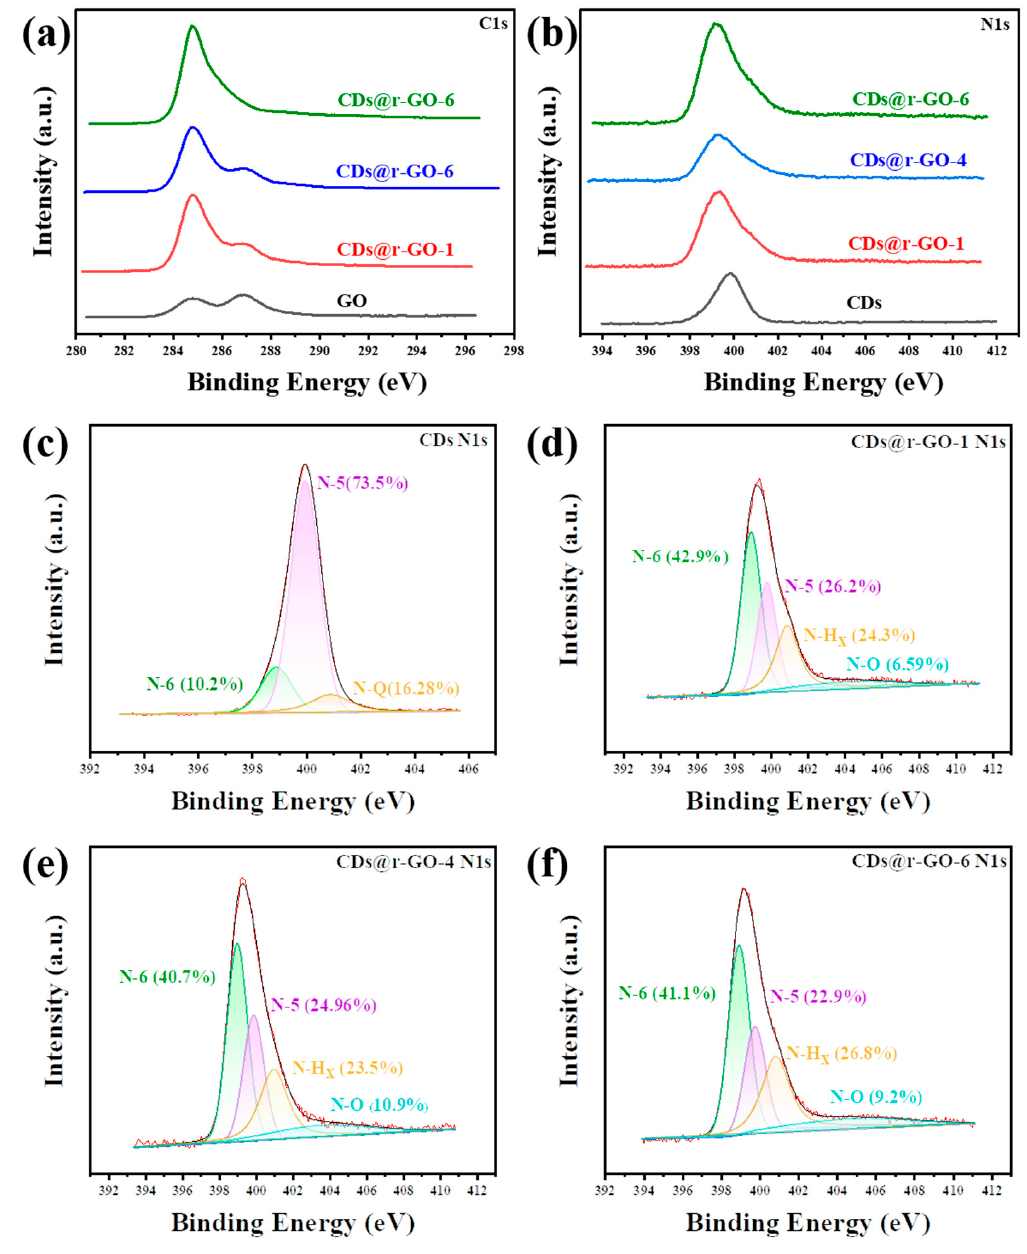
Figure 4. ( a ) XPS C1s spectra and ( b ) N1s spectra of the GO and CDs@GO composite materials. XPS N1s spectra of ( c ) CDs, ( d ) CDs@r-GO-1, ( e ) CDs@r-GO-4 and ( f ) CDs@r-GO-6.